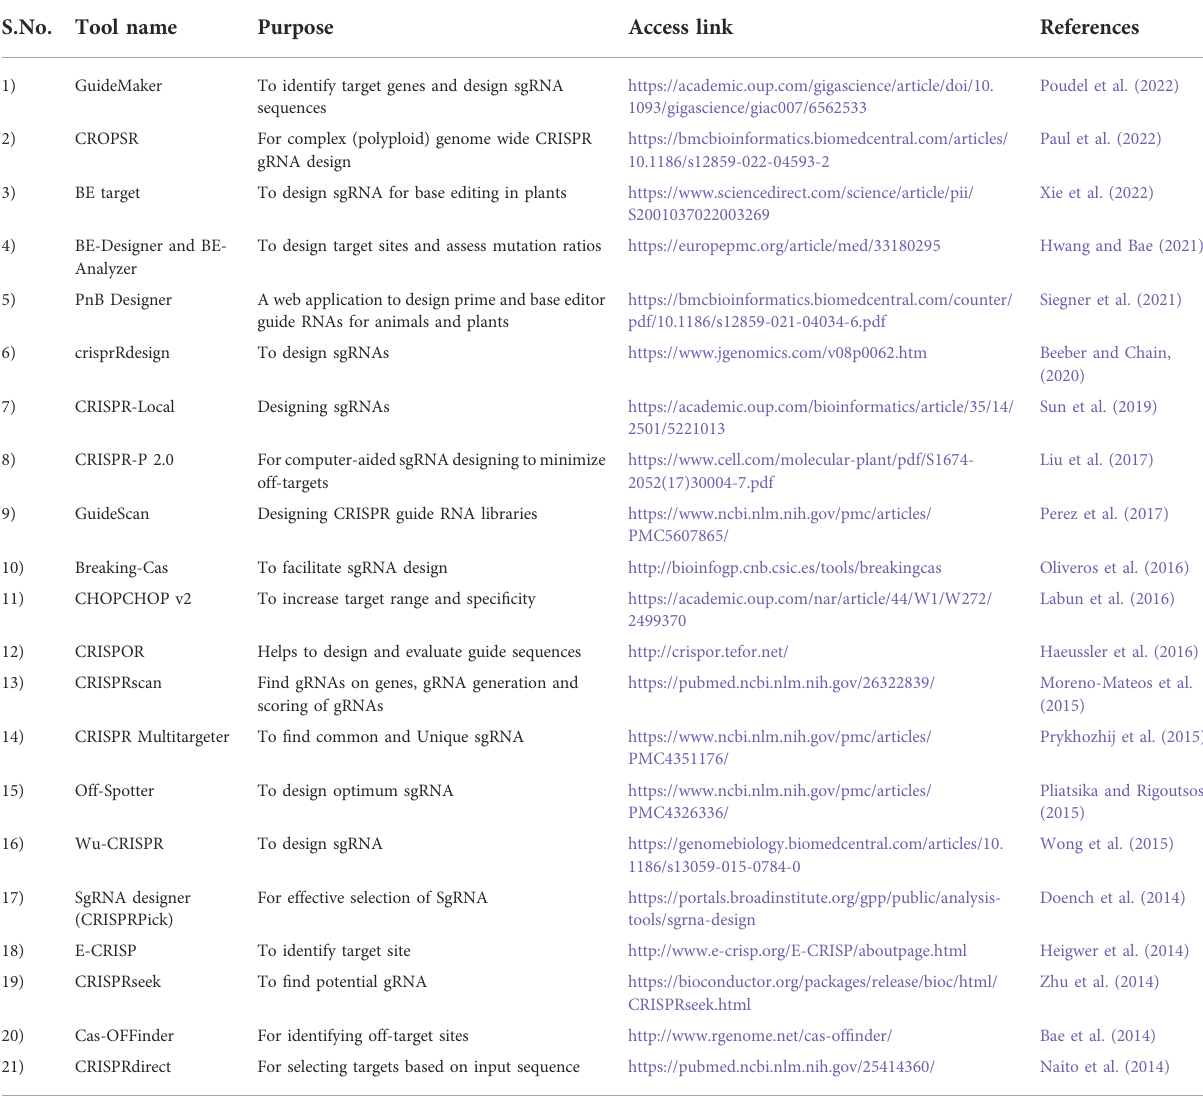
TABLE 1 List of available tools used for CRISPR/Cas9 genome editing.